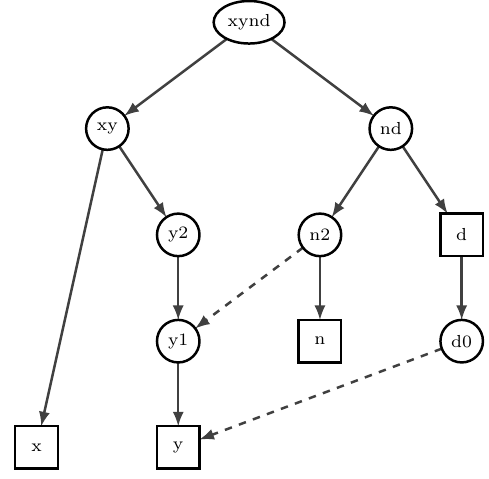
Figure 2 – Network of segments used in legofit analysis. Squares represent seg- ments from which we have “observed” (i.e. simulated) data. Arrows indicate ancestor- descendant relationships, and dashed lines represent gene flow. Segments in the same row need not be